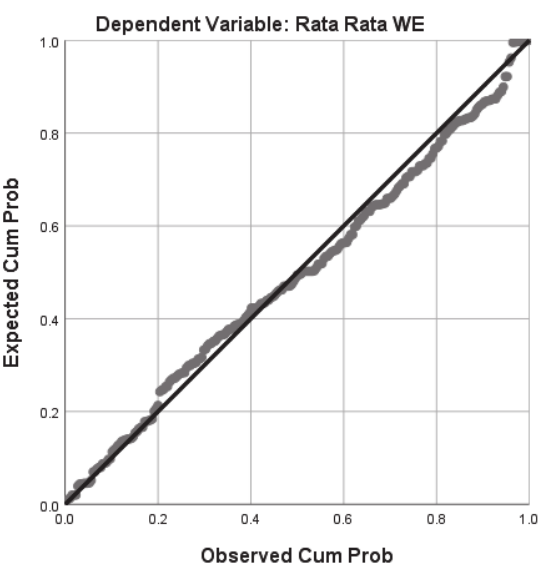
Fig. 3. Work Spirituality, Organizational Commitment, and Work Engagement Normality test results Fig. 3 shows that Workplace spirituality, Organizational Commitment, and Work Engagement model were distributed normally because the data spread followed the diagonal line in the chart (Ghozali, 2013).